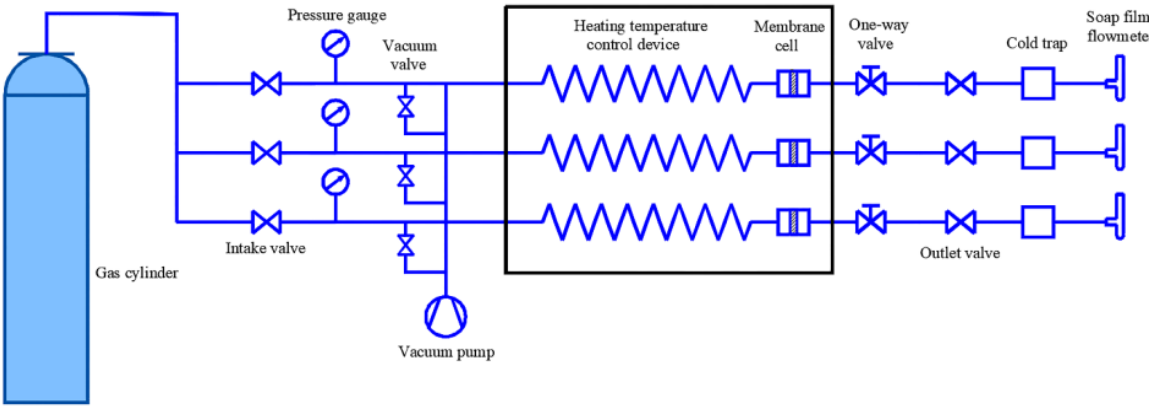
Figure 1. Schematic diagram of experimental devices for permeation measurement of single gas.